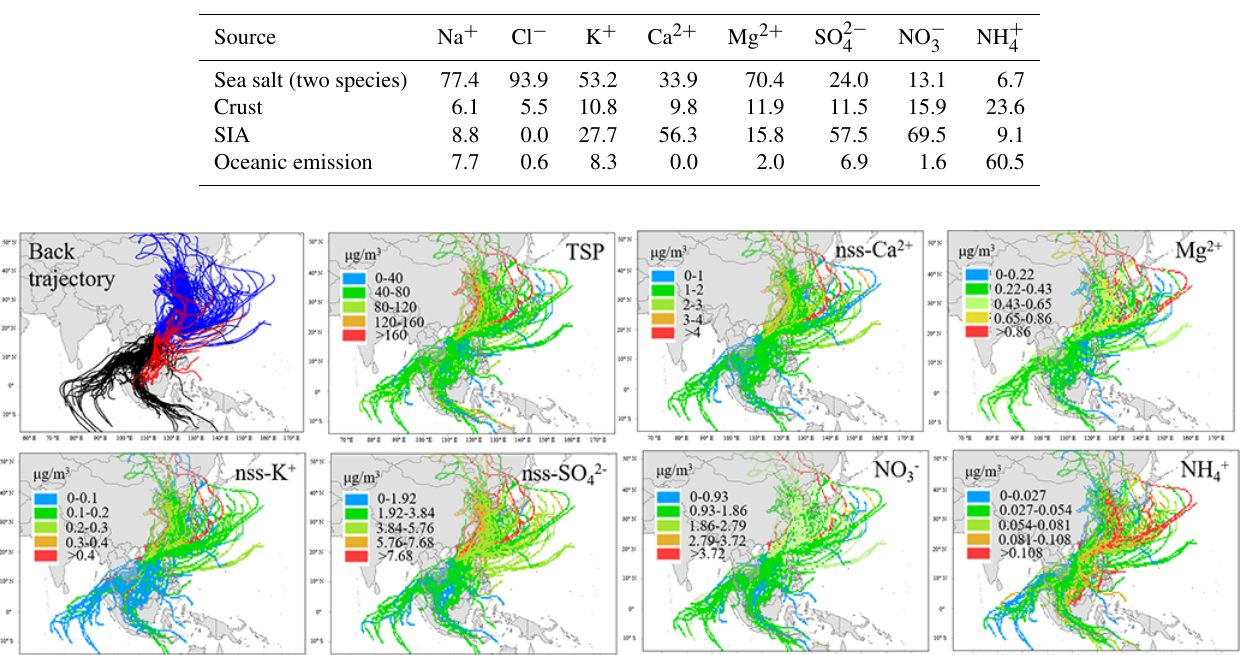
, NO − and NH + at Yongxing Island. 4 3 4